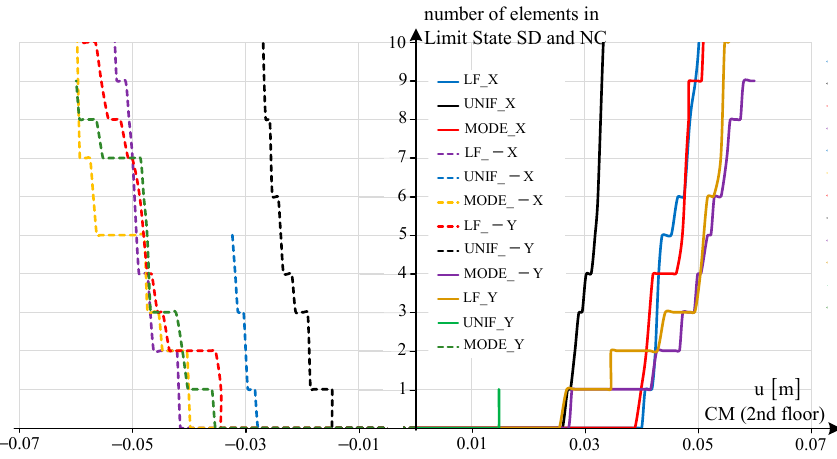
Figure 26. Cumulative number of elements in SD and NC limit state.